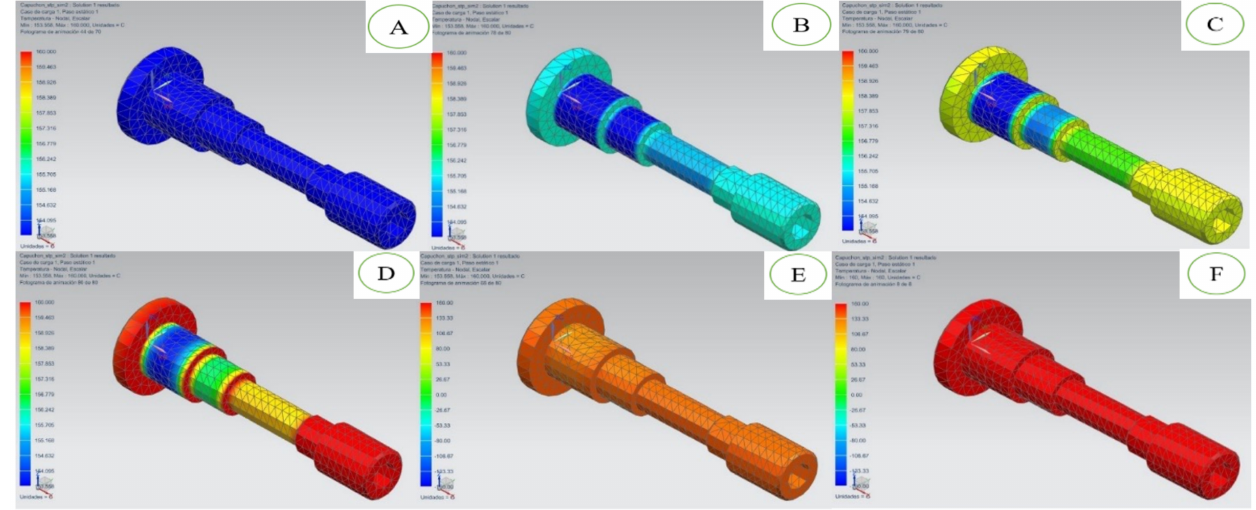
Figure 7. Thermal sequence of polystyrene from ( A – F ) related to the time of